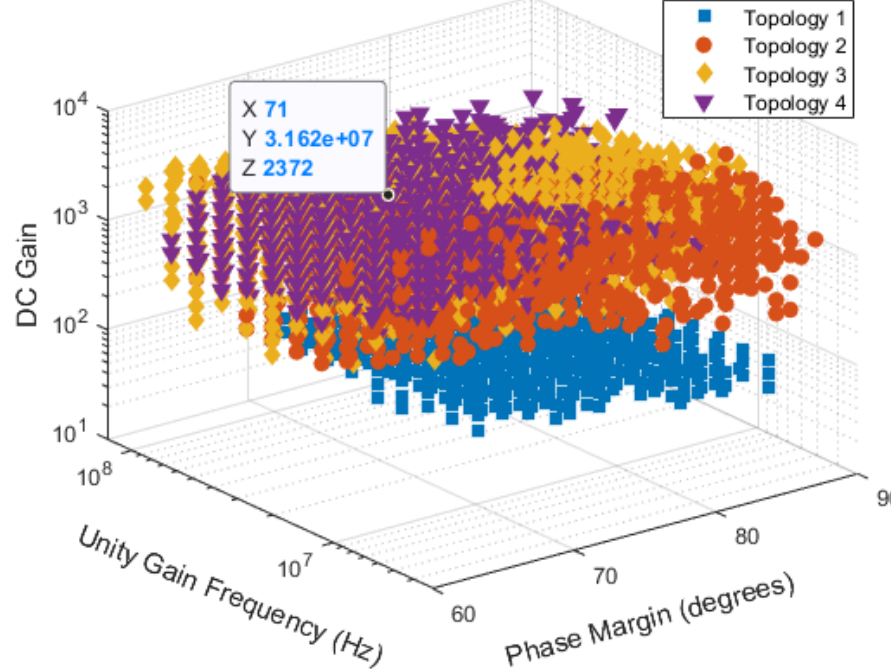
Figure 2. A set of predictions as a function of the DC gain, unity-gain frequency, and the phase margin.